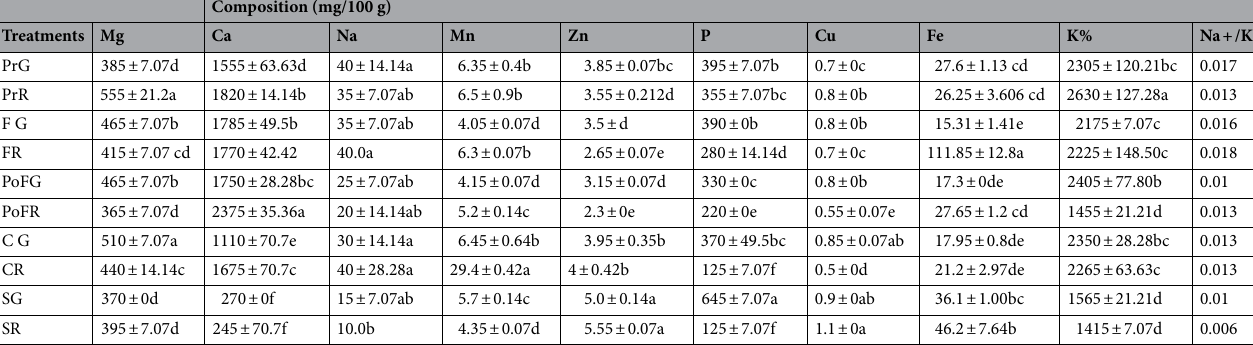
Table 3. Elemental composition of green and red roselle. Values shown are mean ± SD; different letters along a column represent significant differences at p < 0.05 among all the treatments. PrG pre-flowering green, PrR pre- flowering red, FG flowering green, FR flowering red, PoFG post-flowering green, PoFR post-flowering red, CG calyces green, CR calyces red, SG seed green, SR seed red.